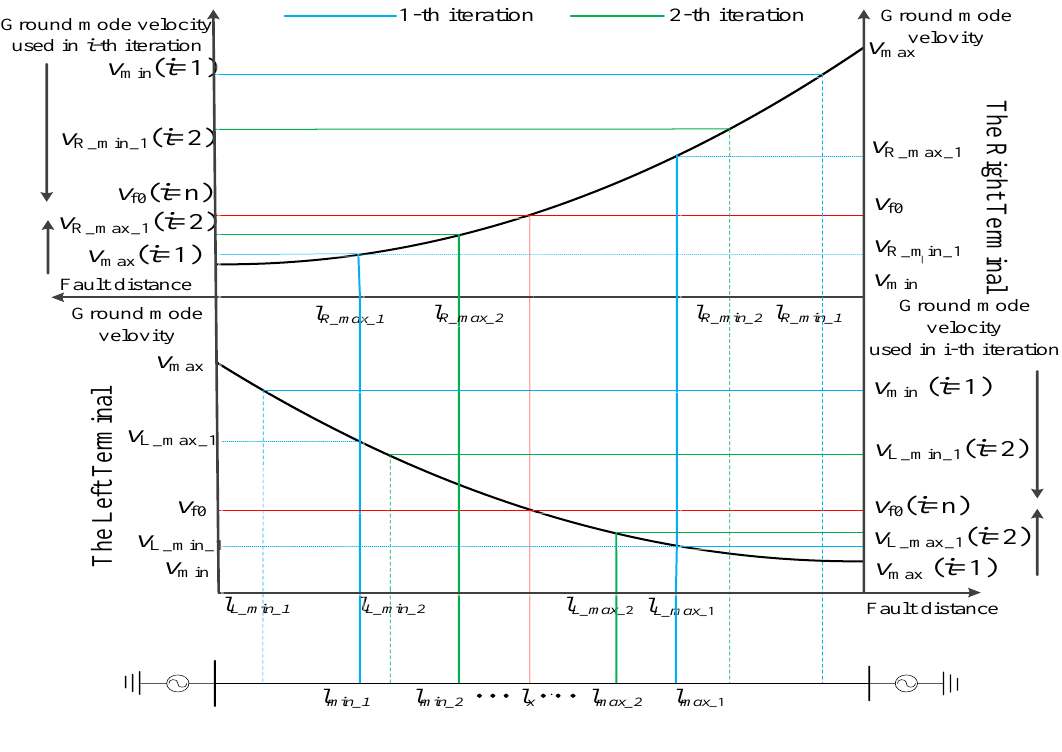
Figure 9. Diagram of iteration.